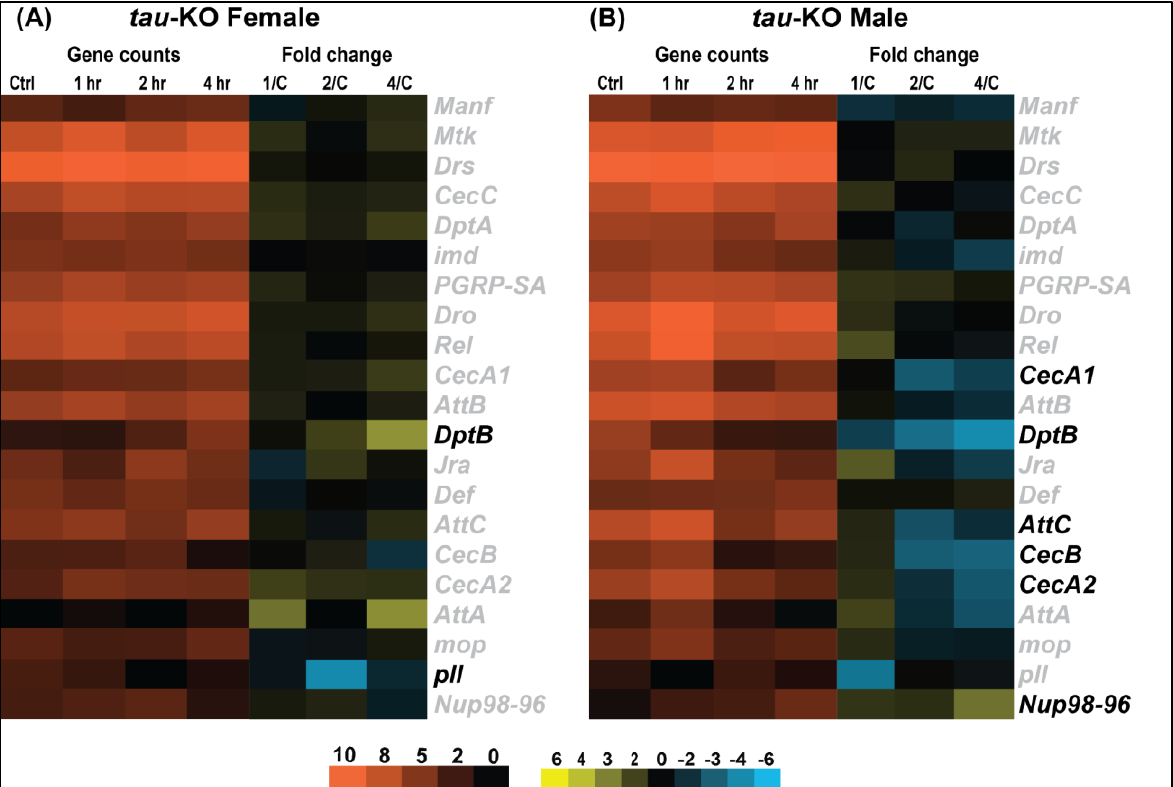
Figure 5. Immune response gene expression appears to be downregulated in tau -KO flies. Heatmaps depicting immune response gene expression changes in tau -KO females ( A ) and males ( B ) at control, 1, 2 and 4 h after injury. Orange scale represents the average of normalized counts for 3 replicates in each group indicated above (n = 3 for each condition: male and female at control, 1, 2, and 4 h post-TBI). Yellow-blue scale shows fold change for each gene at 1, 2- and 4-h post-injury compared to control. All genes indicated in black font are significant (|log2FC| > 1, p -value < 0.05). 1/C: Fold change at 1 h compared to control; 2/C: Fold change at 2 h compared to control and 4/C: Fold change at 4 h compared to control.